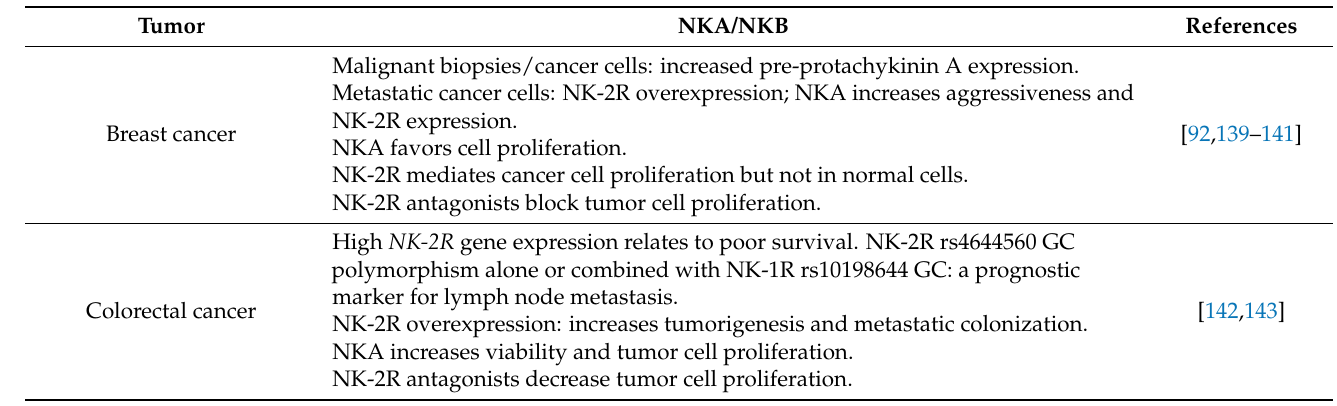
Table 1. Involvement of NKA/NKB in